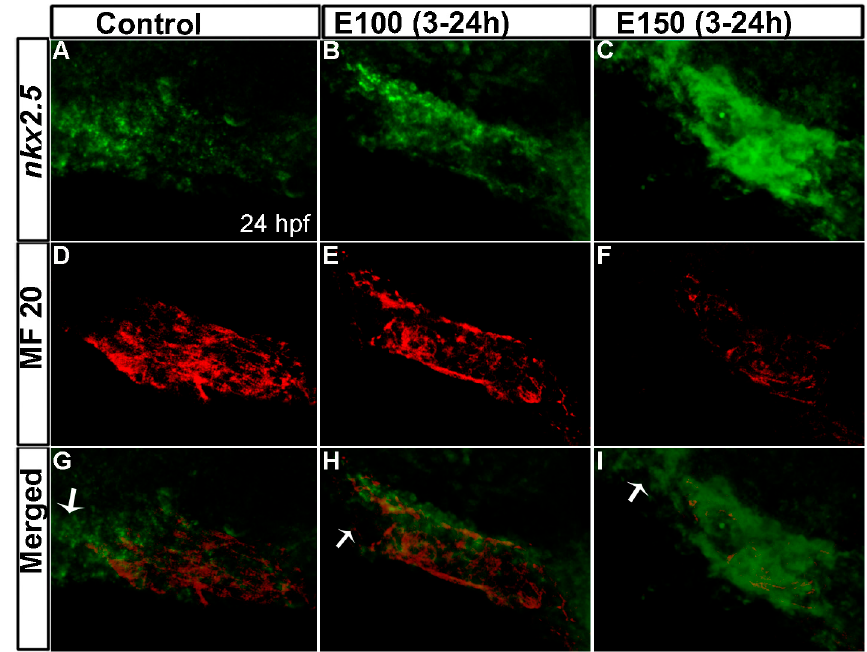
Figure 3. Myocardial differentiation was delayed in ethanol-exposed embryos. ( A – C ) In situ hybridization detecting nkx2.5 expression showed weak nkx2.5 expression in the linear heart tube (indicated fewer undifferentiated FHF derived cells) but strong expression at the outflow pole (indicated arrival of second heart field (SHF) progenitors) in the control embryo ( A ); E100 embryos displayed strong nkx2.5 expression in the linear heart tube but no expression at the outflow pole ( B ); E150 embryos showed strong nkx2.5 expression in the linear heart tube and at the outflow pole ( C ); ( D – F ) Strong MF20 antibody staining in the linear heart tube in control embryos labeled differentiated cardiomyocytes ( D ); MF 20 staining was weaker in the heart tube in ethanol-treated embryos ( E , F ); ( G – I ) Co-labeled images showed myocardial differentiation delay in ethanol-exposed embryos. White arrows: pointing to the outflow pole.